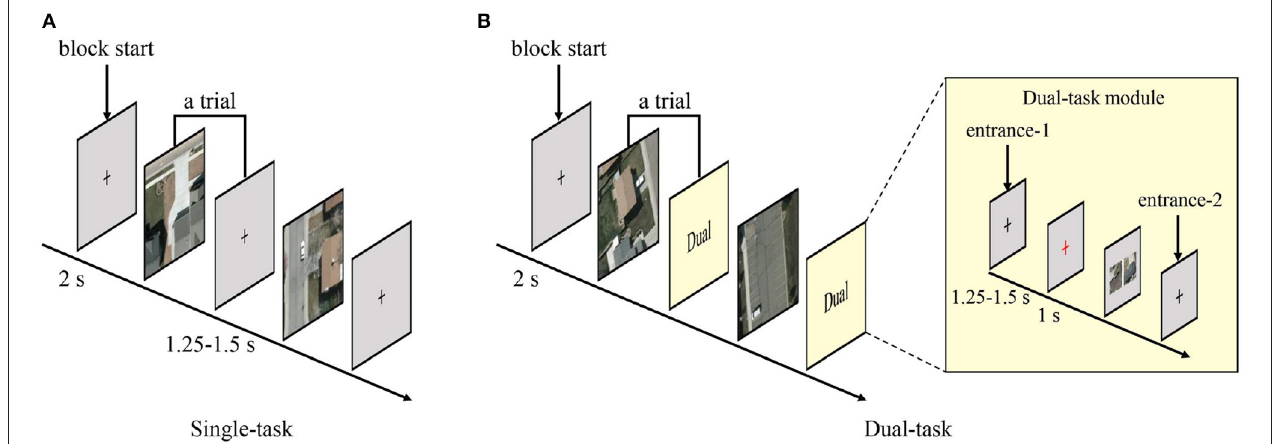
FIGURE 4 | Temporal structures of stimulus presentation. (A) Paradigm of the single-task. Each trial consisted of a vehicle detection stimulus and an inter-stimulus interval. (B) Paradigm of the dual-task. Each trial consisted of a vehicle detection stimulus and a dual-task module. One-third trials entered the dual-task module from entrance-1 and the remaining trials from